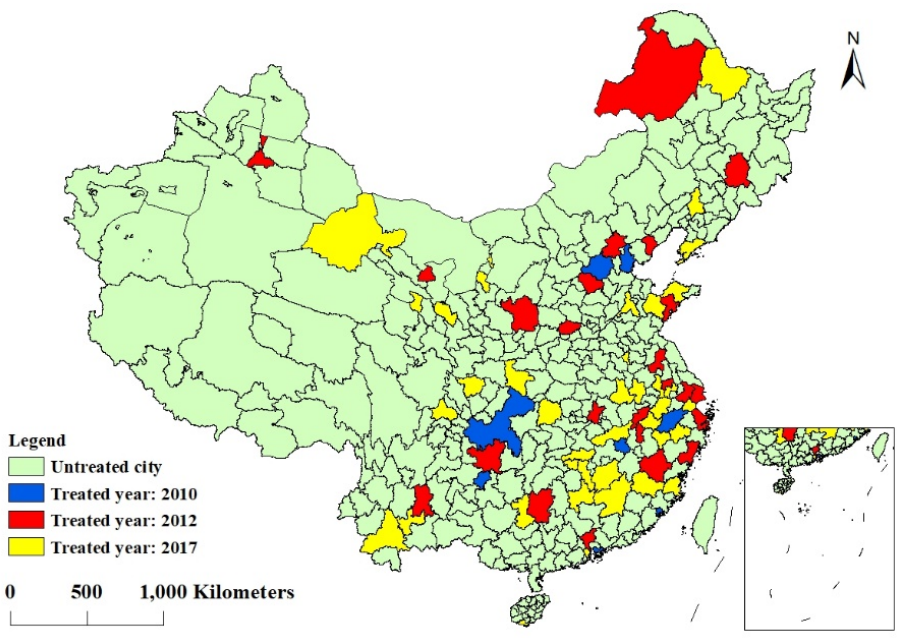
Figure 2. Spatial distribution of pilot low-carbon cities. Table 1. Low-carbon city pilot policy process.